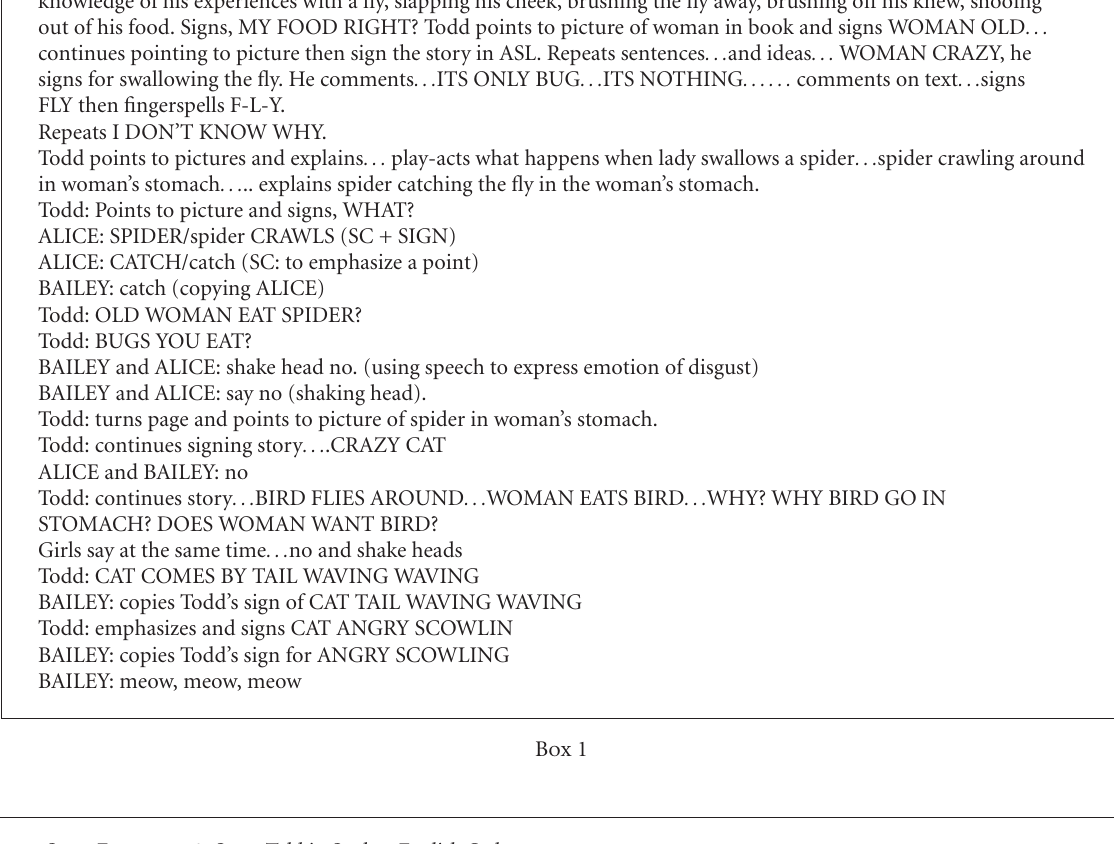
Story no.1 Excerpt: Todd Signs Story in ASL Todd makes the sign for fly with his hands and flies toward the kids and makes them laugh. He provides background knowledge of his experiences with a fly, slapping his cheek, brushing the fly away, brushing o ff his knew, shooing out of his food. Signs, MY FOOD RIGHT? Todd points to picture of woman in book and signs WOMAN OLD ... continues pointing to picture then sign the story in ASL. Repeats sentences ... and ideas ... WOMAN CRAZY, he signs for swallowing the fly. He comments ... ITS ONLY BUG ... ITS NOTHING ...... comments on text ... signs FLY then fingerspells F-L-Y. Repeats I DON’T KNOW WHY. Todd points to pictures and explains ... play-acts what happens when lady swallows a spider ... spider crawling